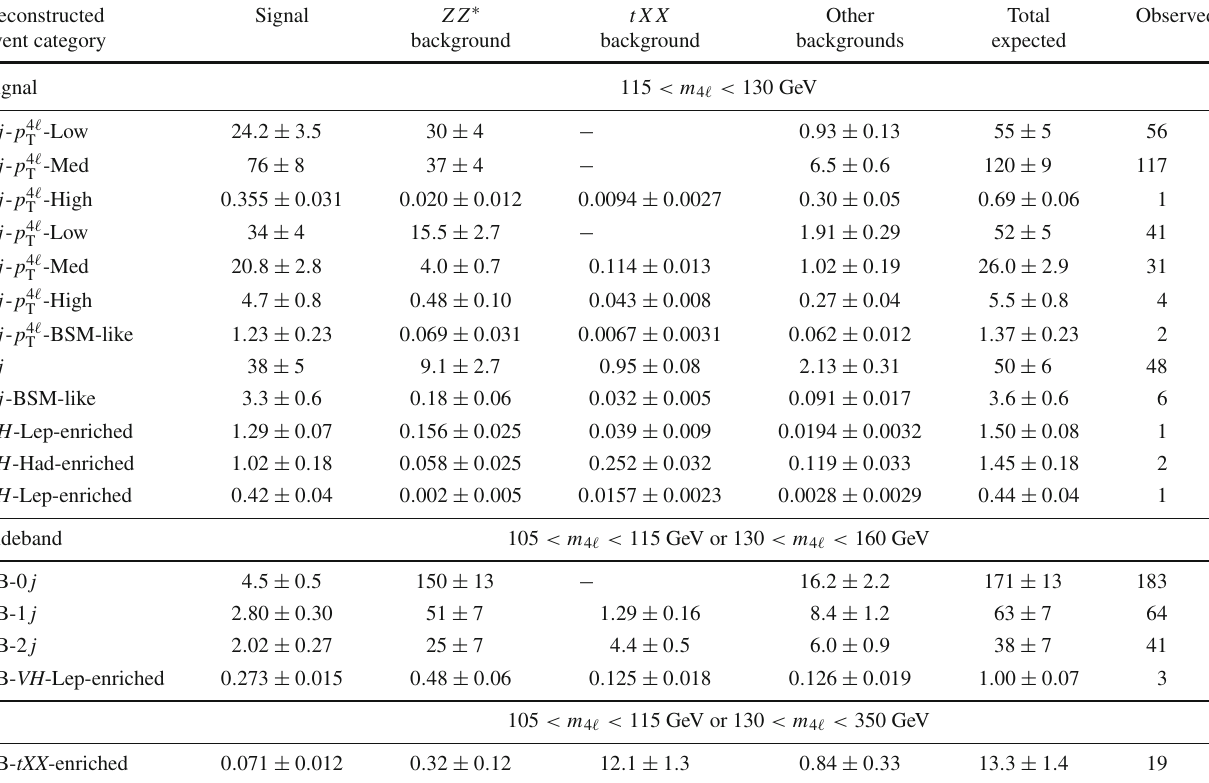
Table 7 The expected (pre-fit) and observed numbers of events for an boson events and the estimated background yields is compared with the √ integrated luminosity of 139 fb − 1 at data. Combined statistical and systematic uncertainties are included for s = 13 TeV in the signal region the predictions. Expected contributions that are below 0.2% of the total 115 < m 4 (cid:4) < 130 GeV and sideband region 105 < m 4 (cid:4) < 115 GeV yield in each reconstructed event category are not shown and or 130 < m 4 (cid:4) < 160 GeV (350 GeV for tXX -enriched) in each recon- structed event category assuming the SM Higgs boson signal with a mass m H = 125 GeV. The sum of the expected number of SM Higgs